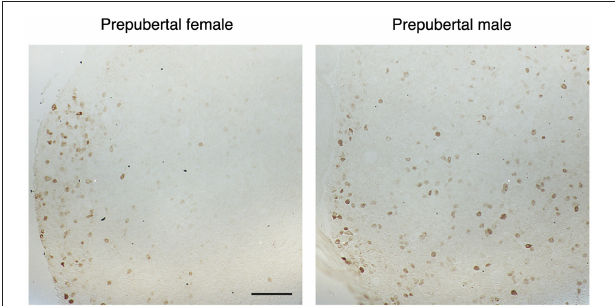
FIGURE 3 | The sex-specific expression pattern of osteopontin (OPN) in the anterior pituitary tissue from prepubertal female and male rats. Male tissue sections contained greater number of labeled cells which were more homogenously distributed, when compared to female pituitary tissue. Scale bar of 200 µ m applies to both